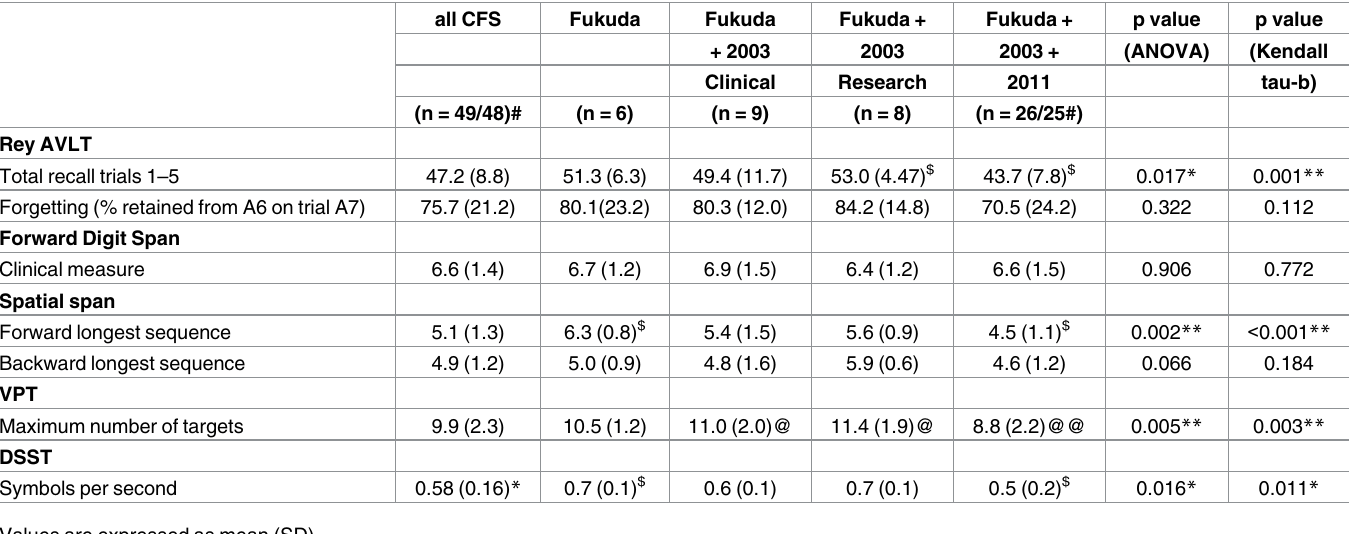
Table 5. Cognitive testing by